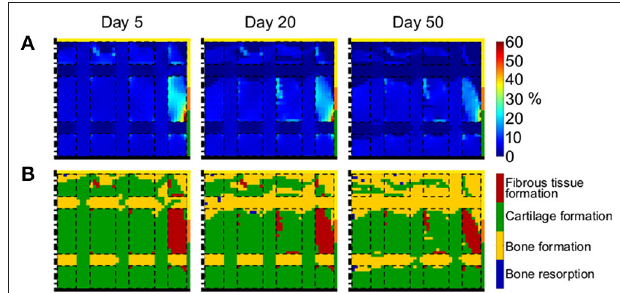
FIGURE 7 | Mechanical environment in the osteochondral defect with scaffold having biphasic mechanical properties. (A) Distribution of γ ; (B) prediction of tissue formation based on S. Left, middle, and right columns show results at day 5, 20, and 50, respectively. The scale bars to interpret the plots are on the left side of the corresponding rows. The black dash-dot lines and the black solid lines mark the axis of symmetry and the articular interface, respectively. The colors of the borders indicate the neighboring tissues in the FE model of the femoral condyle: yellow, orange, and green stand for cancellous bone, subchondral bone, and cartilage, respectively. The black dashed rectangles mark the struts of the scaffold.